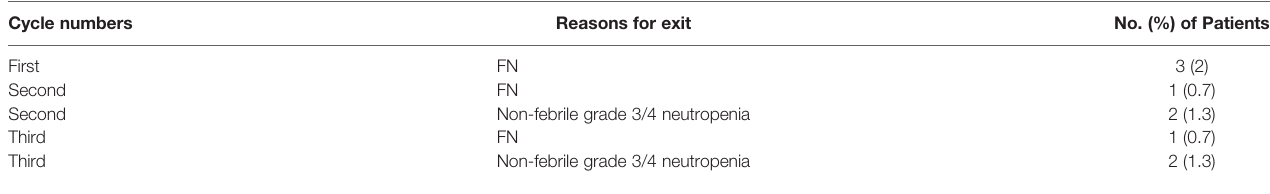
TABLE 2 | Reasons and time points of nine patients exited the study.